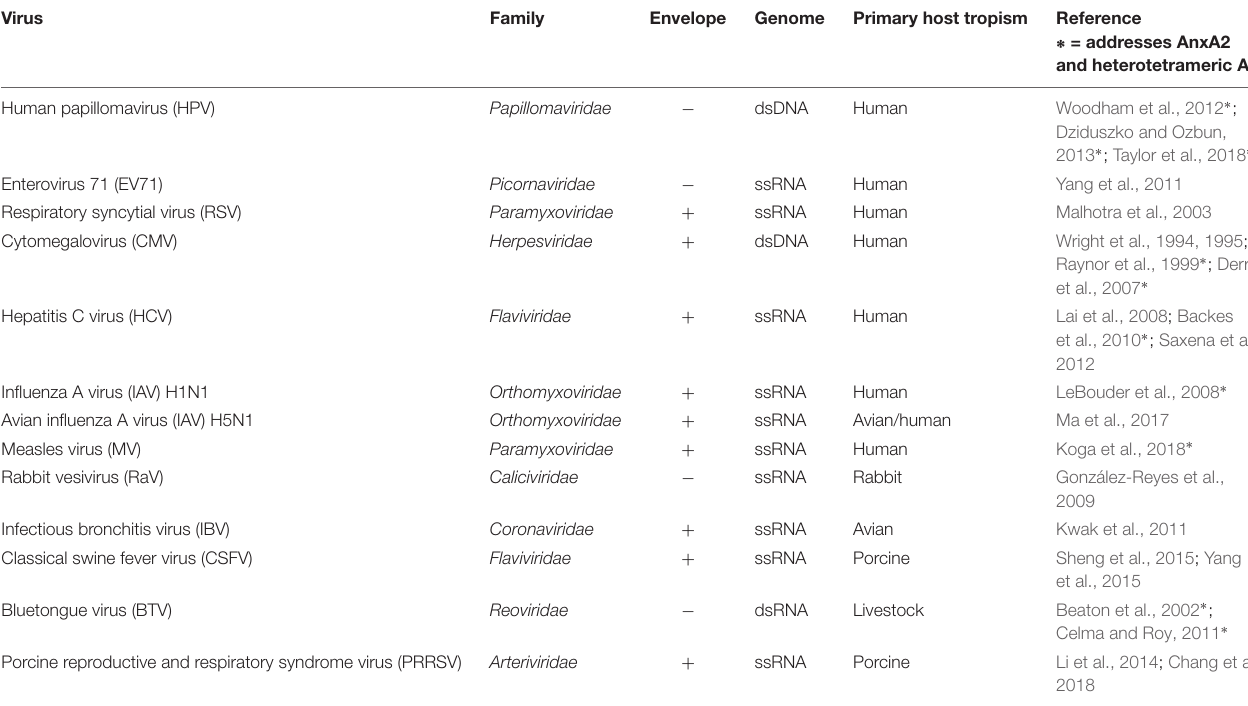
TABLE 1 | Epithelial cell-targeting viruses that utilize Annexin